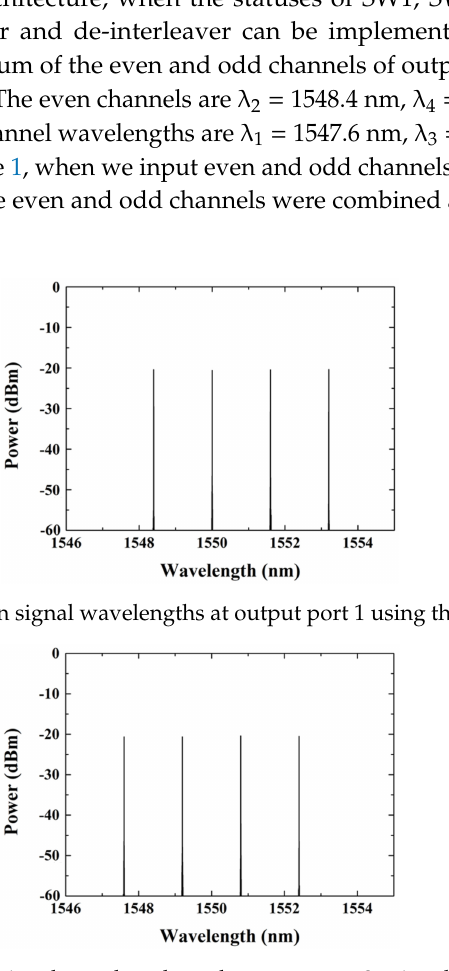
Figure 5. The spectrum of odd signal wavelengths at the output port 2 using the de-interleaver